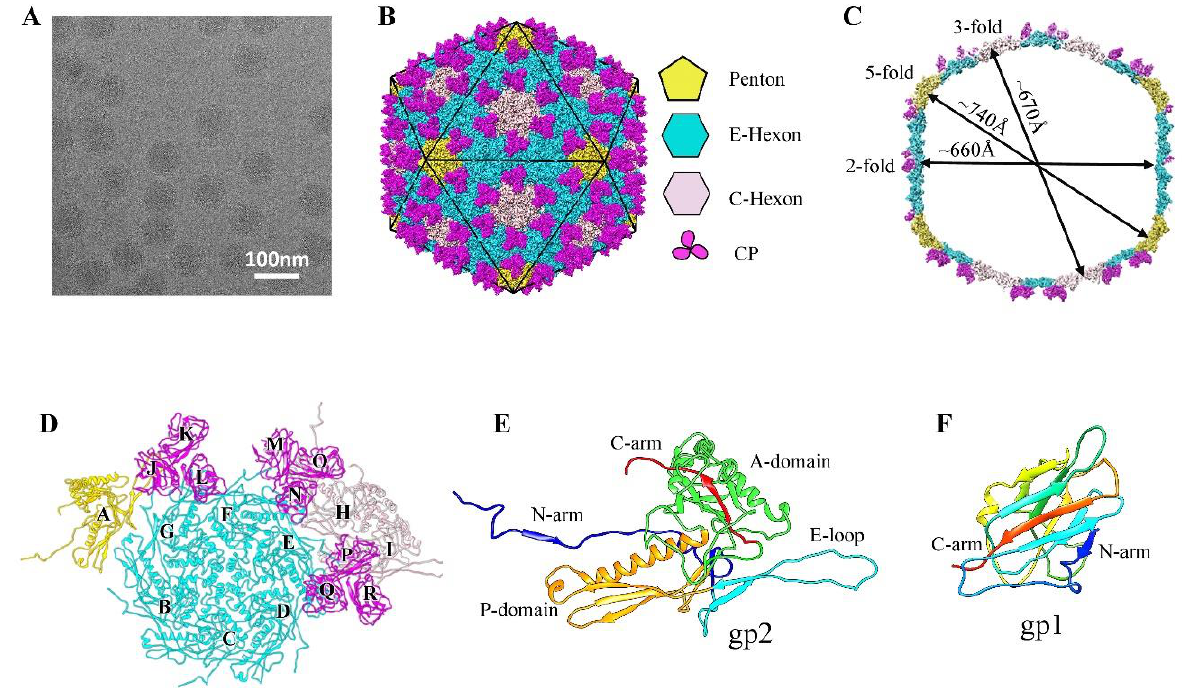
Figure 1. Overall structure of the GP4 head. ( A ) A representative cryo-EM image of the frozen-hydrated GP4. ( B ) Overall density map of the mature GP4 head. The densities of pentons, E-hexons, C-hexons, and cement protein trimers are colored gold, cyan, pink, and magenta, respectively. ( C ) Central cross section of the density map viewed along an icosahedral two-fold axis. The diameters of the outermost surface along the icosahedral five-, three-, and two-fold axes are labeled. ( D ) The ribbon models of the 9 MCP monomers (labeled A–I) and 9 CP monomers (labeled J–R) in the asymmetric unit of the icosahedron. The view and the color schedule are the same as in ( B ). ( E ) Secondary structure of the MCP gp2 shown in four domains: N-arm in blue, E-loop in cyan, P-domain in orange, and A-domain in green and red. The C-terminal of gp2 is colored red. ( F ) Secondary structure of the CP gp1 rainbow-colored from the N-terminus in blue to the C-terminus in red.